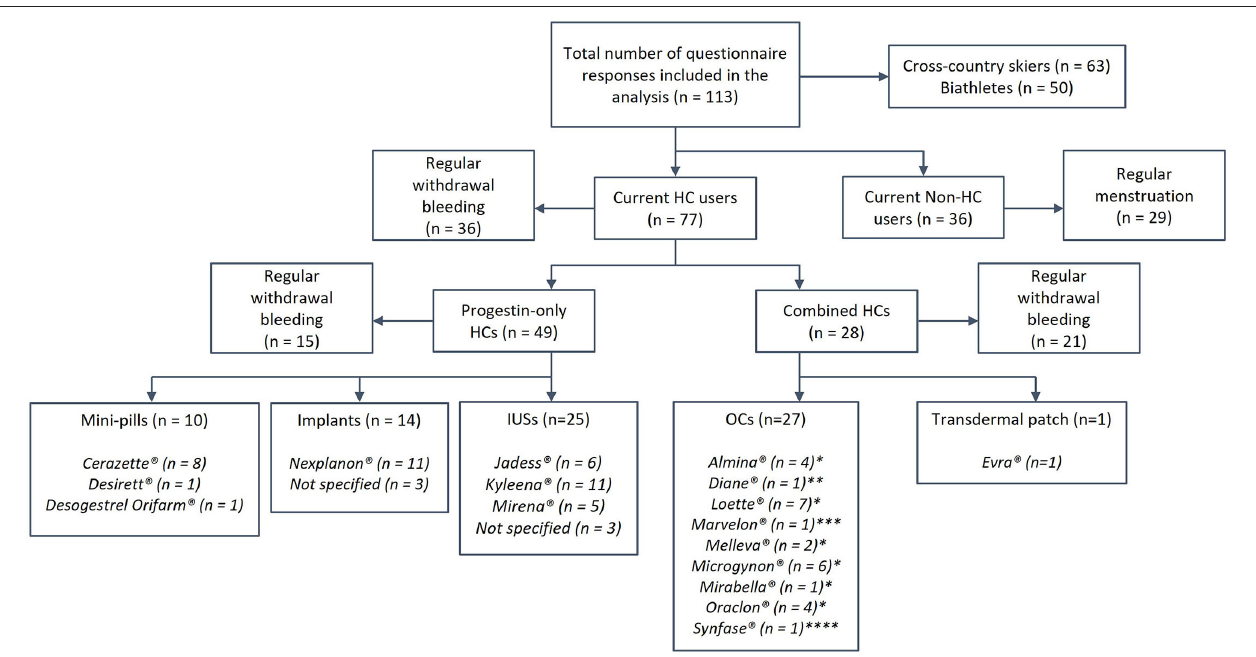
FIGURE 1 | The prevalence of type, delivery methods, and preparations of hormonal contraceptives (HCs) used. Concentration of synthetic hormones in the different delivery methods: Mini-pills, 75 µ g Desogestrel; Implants, ∼ 40 µ g Etonogestrel in 24 h over 3 y; Intrauterine devices (IUSs), 6–15 µ g Levonorgestrel in 24h over 3–6 y; Oral contraceptives (OCs), * 20–30 µ g Ethinyl estradiol (EE) and 100–150 µ g Levonorgestrel, **35 µ g EE and 2,000 µ g Cyproterone acetate, ***30 µ g EE and 150 µ g Desogestrel, ****35 µ g EE and 500–1,000 µ g Noretisterone; Transdermal patch, 33.9 µ g EE and 203 µ g Norelgestromin in